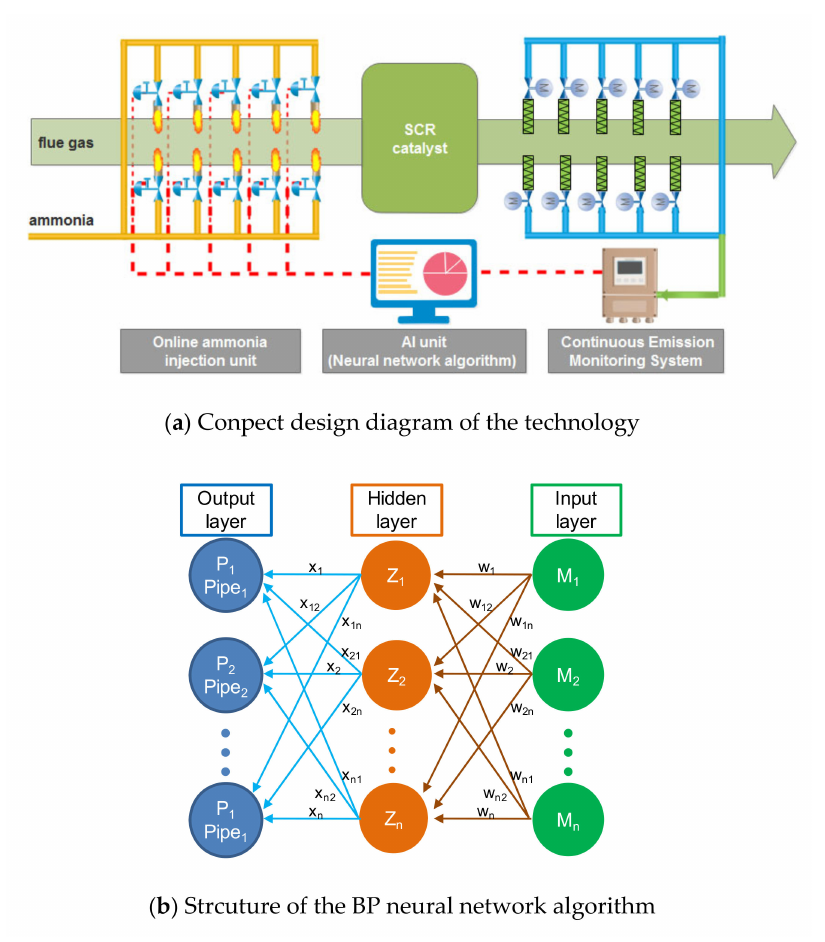
Figure 9. Concept of the real-time self-feedback ammonia injection